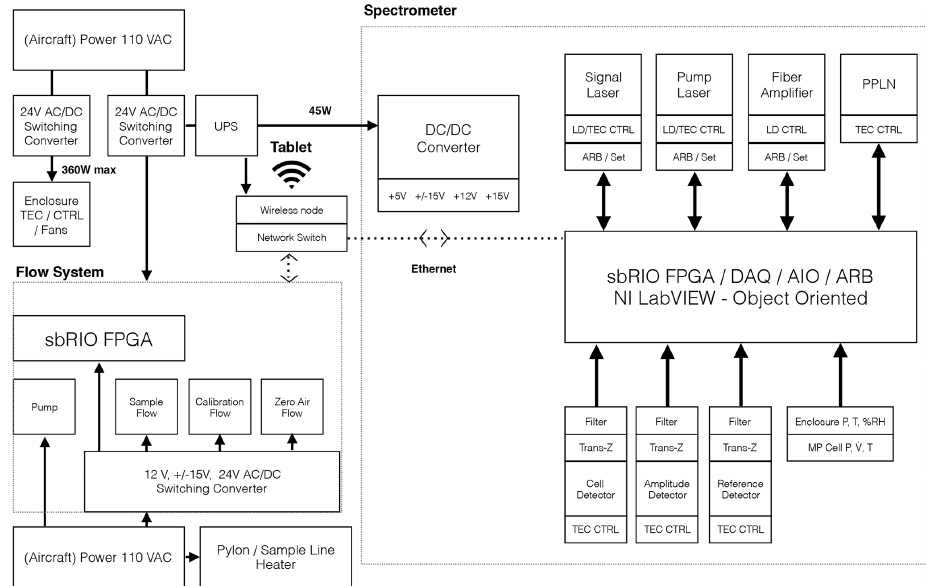
Figure 3. Electronics and power schematic. UPS: uninterruptible power system; LD: laser diode; TEC: thermoelectric cooler; CTRL: con- troller; ARB: arbitrary waveform output; Set: set-point voltage output; DAQ: data acquisition; AIO: analog input–output; Trans-Z: trans- impedance amplifier; P : pressure; T : temperature; V : volumetric flow.